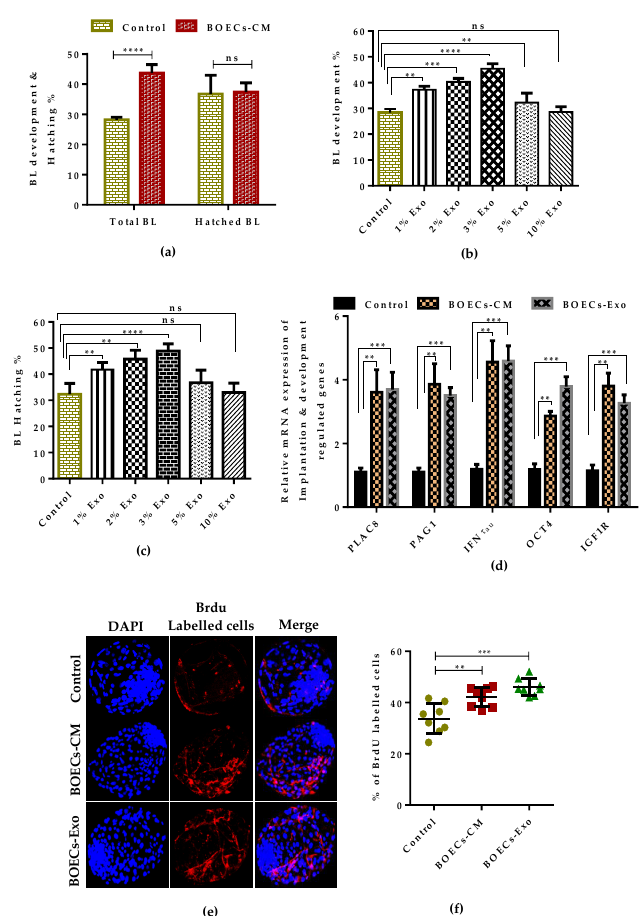
Figure 3. Effect of BOECs monolayer derived CM and Exo supplementation on bovine BL yield and quality. ( a , b ) Representative bar graph showing the development and hatching % of BLs cultured in the absence or presence of BOECs-CM and di ff erent concentration of Exo. Data are presented as a result of ± SEM (standard error of mean) of 11 and 8 replicates, respectively. ( c ) qRT-PCR analysis of the expression profile of several BL implantation potential and development competence-related genes in response to BOECs-CM and 3% Exo supplementation. ( d , e ) Immunofluorescence analysis showing the labelling of 5-bromo-2 (cid:48) -deoxyuridine (BrdU) in day-8 BLs cultured in the absence or presence of BOECs-CM and 3% Exo. ( f ) Quantification of BrdU labelled cells. Bar graph data represent means ± SEM (standard error of mean) from triplicate experiments, performed with n = 20 BLs per group in each replicate. ** p < 0.01; *** p < 0.001; **** p < 0.0001 denotes significant di ff erence. Original magnification is 100 ×